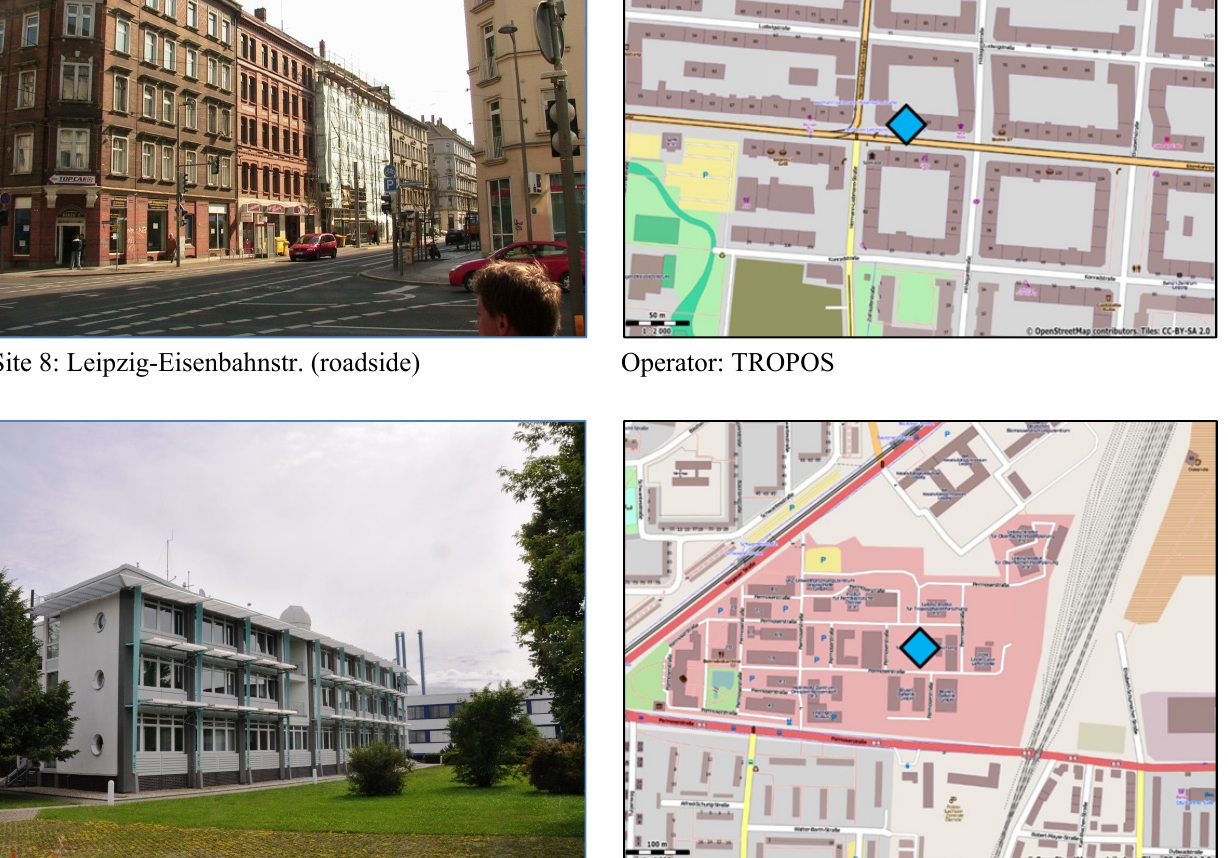
Earth Syst. Sci. Data, 8, 355–382, 2016